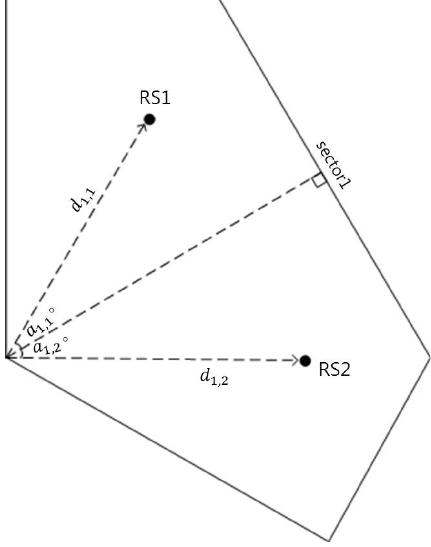
Figure 4. RS location using a polar